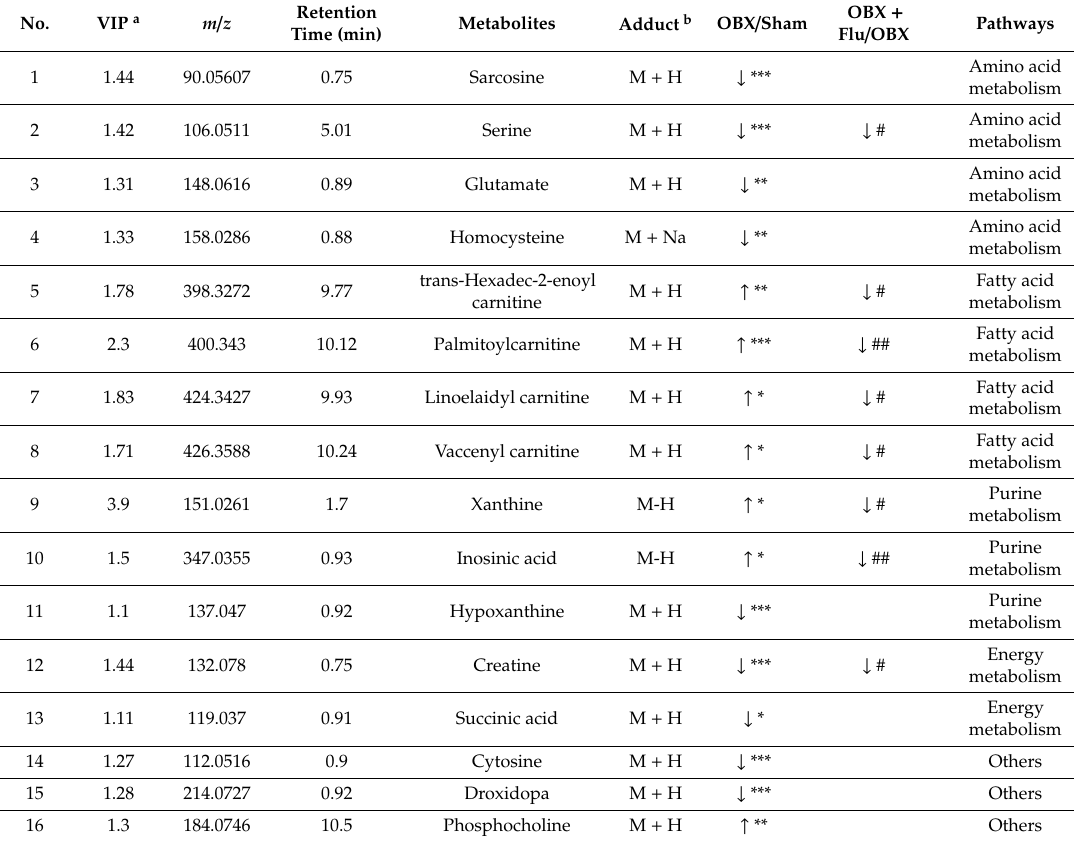
(Figure 6). The a ff ected pathways recognized by the KEGG Pathway Database (https: // www.kegg. jp / kegg / pathway.html) were involved in amino acid metabolism, fatty acid metabolism, purine metabolism, and energy metabolism. Table 1. Identified biomarkers in the hippocampus of rats subjected to OBX and fluoxetine treatment.